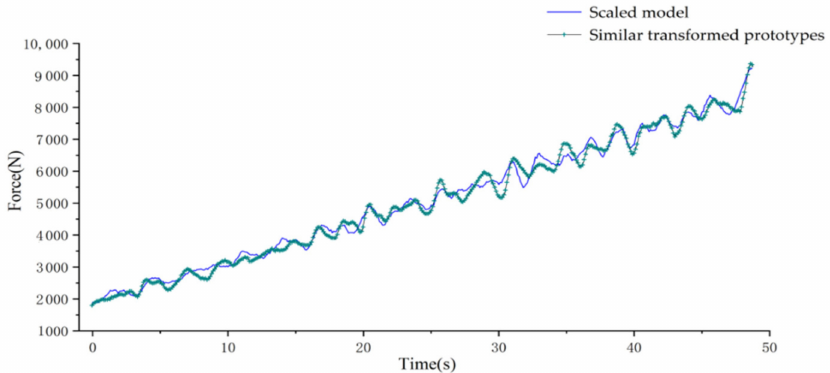
Figure 13. Comparison of forces at articulated points of tower and deck.